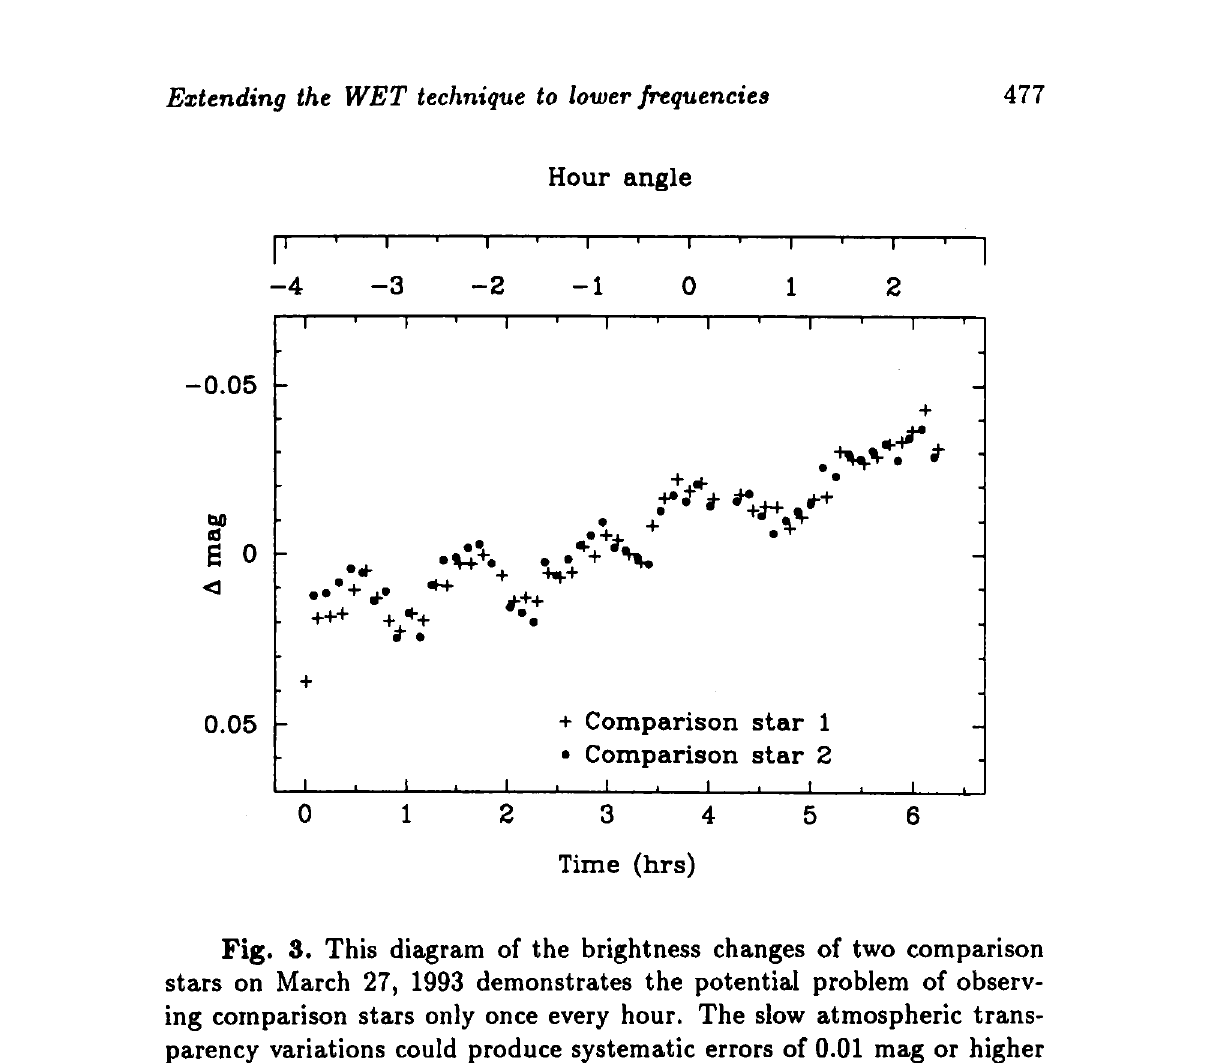
Fig. 3. This diagram of the brightness changes of two comparison stars on March 27, 1993 demonstrates the potential problem of observ- ing comparison stars only once every hour. The slow atmospheric trans- parency variations could produce systematic errors of 0.01 mag or higher with spurious power in the 300 /zHz